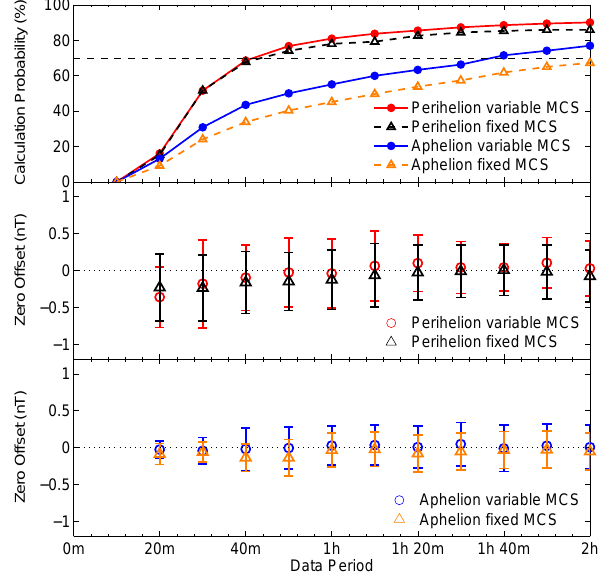
Fig. 5. Top panel: offset calculation probabilities for aphelion and perihelion 1976, Helios 2. Middle panel: average zero offsets cal- culated at perihelion. Bottom panel: average zero offsets calculated at aphelion. The variable MCS points represent our new automated method and the fixed MCS points represent a comparison with pre- vious implementations of the Leinweber et al. (2008)